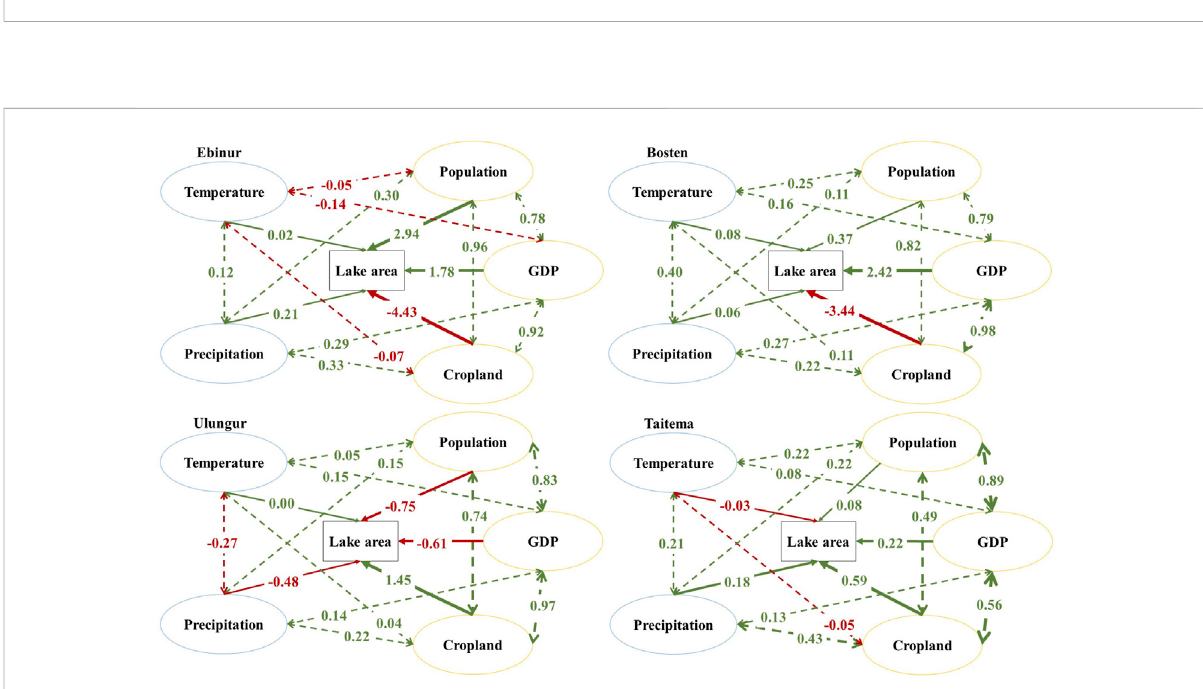
FIGURE 10 Results of structural equation model analysis of the in fl uencing factors of typical plains lake area changes in